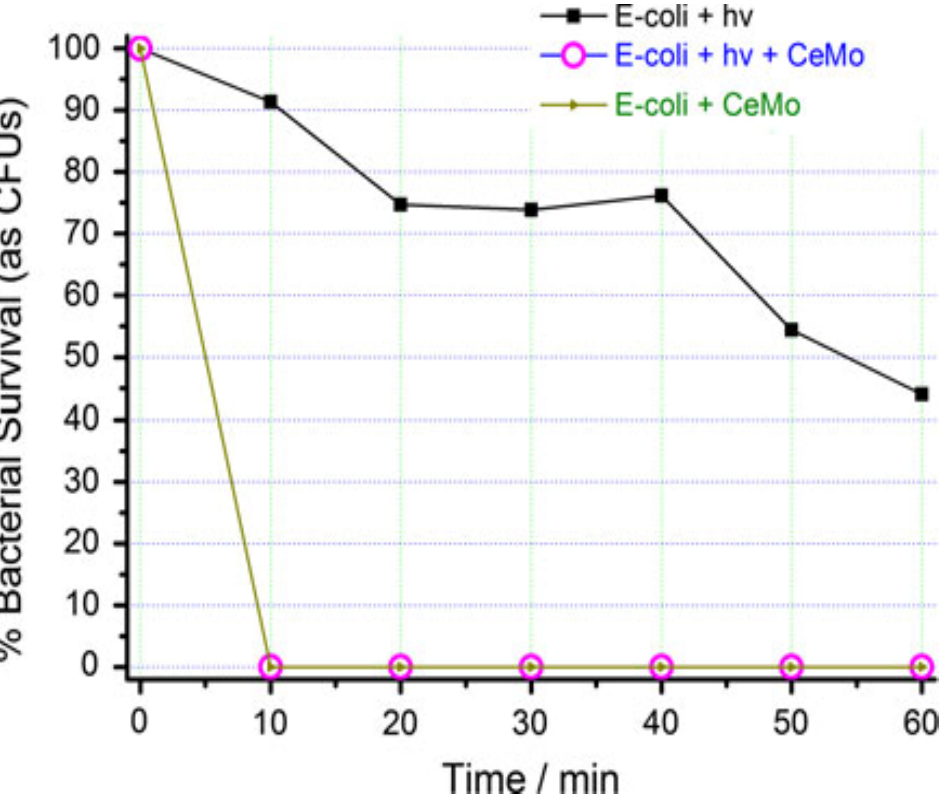
Figure 9. Bacterial survival in CeMo hollow nanospheres’ presence with or without light